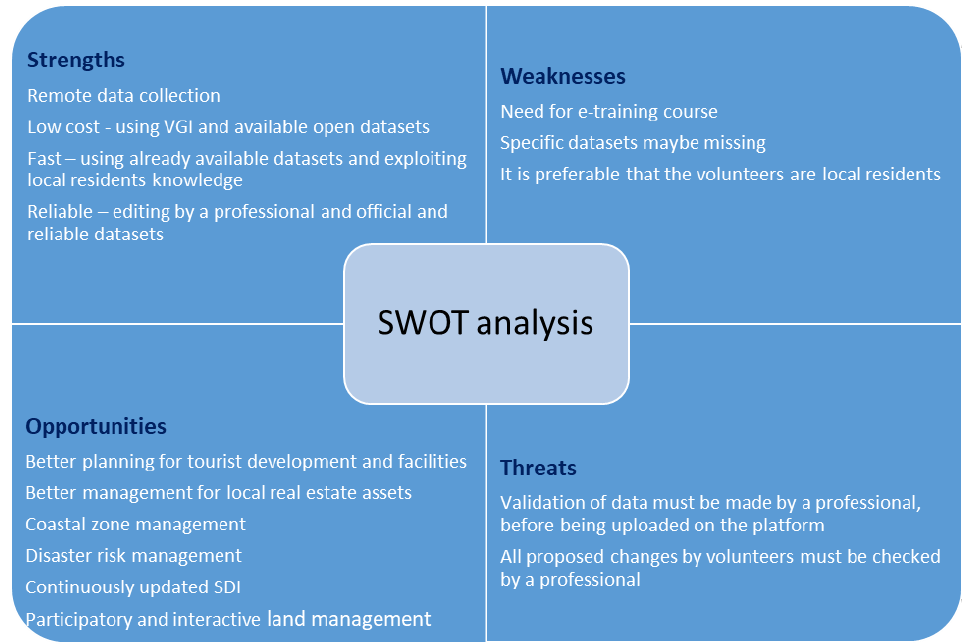
Figure 7. SWOT analysis.